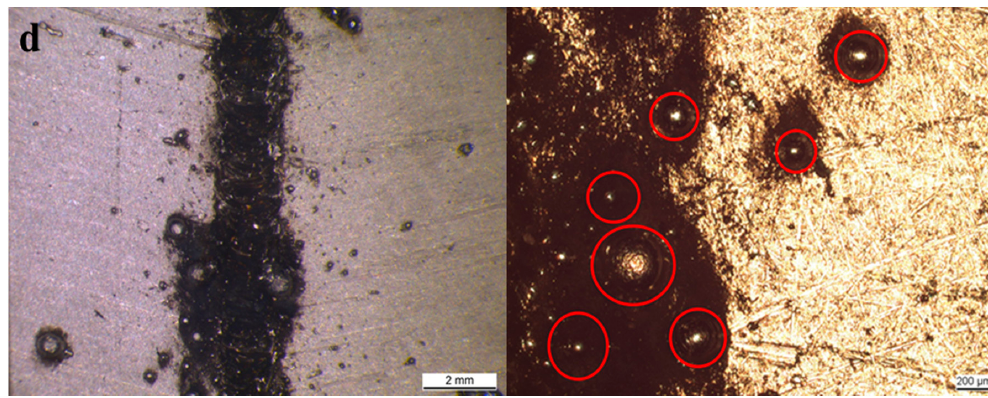
Figure 2. Optical microscopy images of seams in case of laser welding of AlMg5 parts under Ar. Laser peak power of 5.5 kW and pulse duration of ( a ) 1 ms; ( b ) 2 ms; ( c ) 3 ms; and ( d ) 6 ms, respectively. Red circles are marking droplets present around the seam.